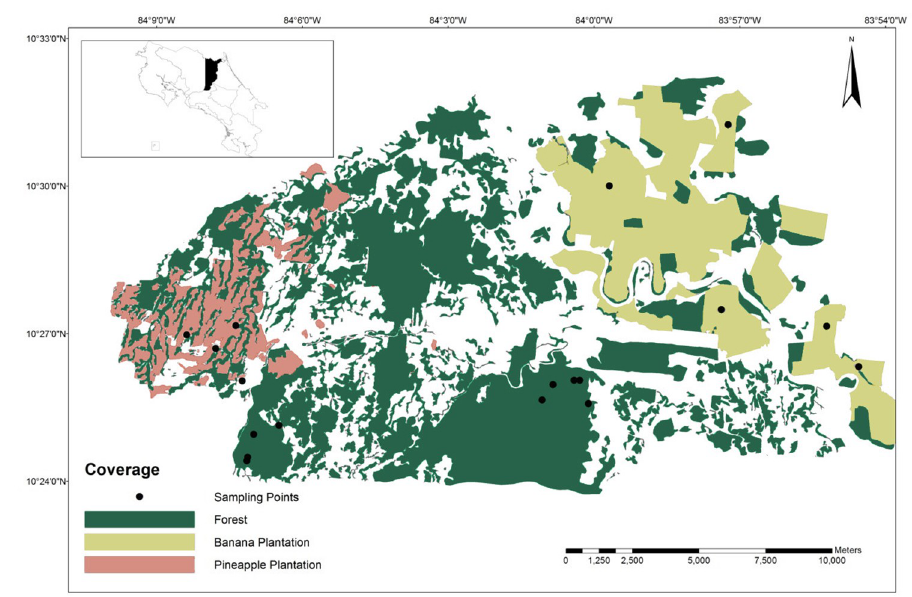
Fig 1. Map of the study area and the acoustic monitoring sites for bats in forest and plantation habitats, within Sarapiquı´, Costa Rica. Image sources: Mosaic generated in SIG OTS from aerial photographies issued by the Costa Rica Airborne Research and Technology Applications (CARTA 2005), Centro Nacional de Alta Tecnologı´a (CENAT) and Nasa Johnson Space Center (2014). Elaborated by M. Runnebaum.